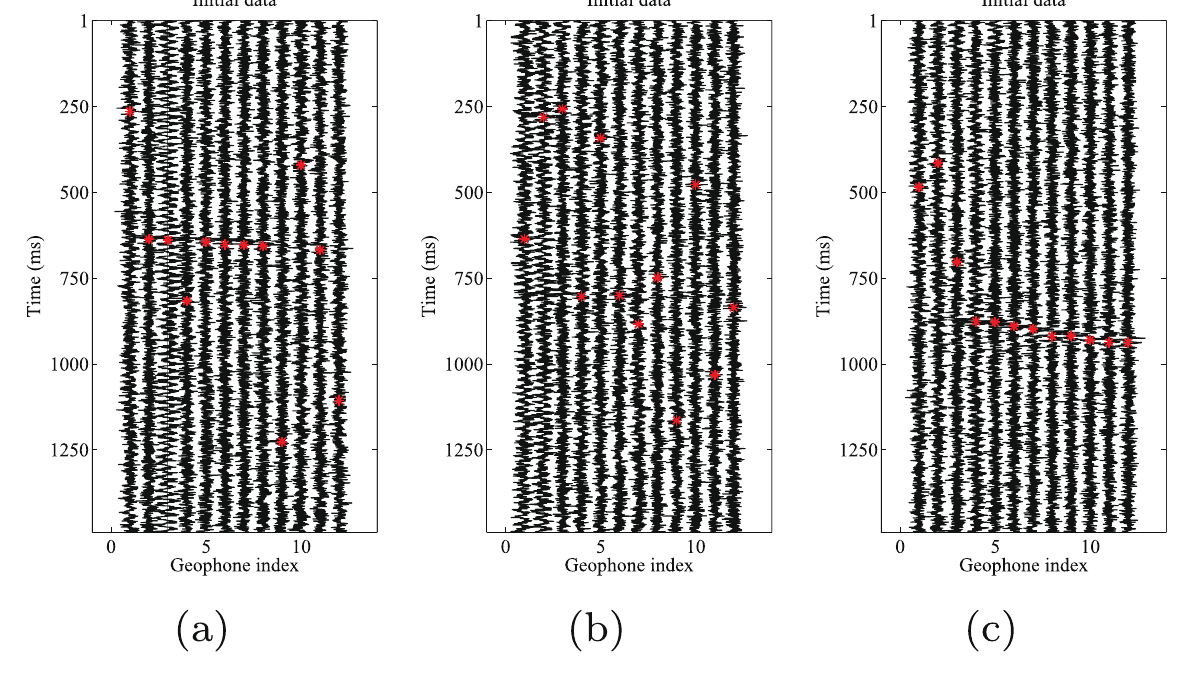
Figure 12. Arrival picking of the initial data. ( a ) Horizontal component (H1). ( b ) horizontal component (H2). ( c ) Vertical component (V).